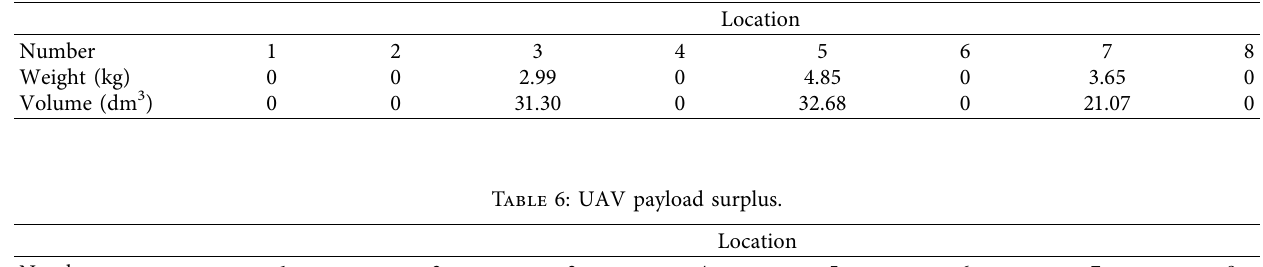
Table 5: Goods surplus.